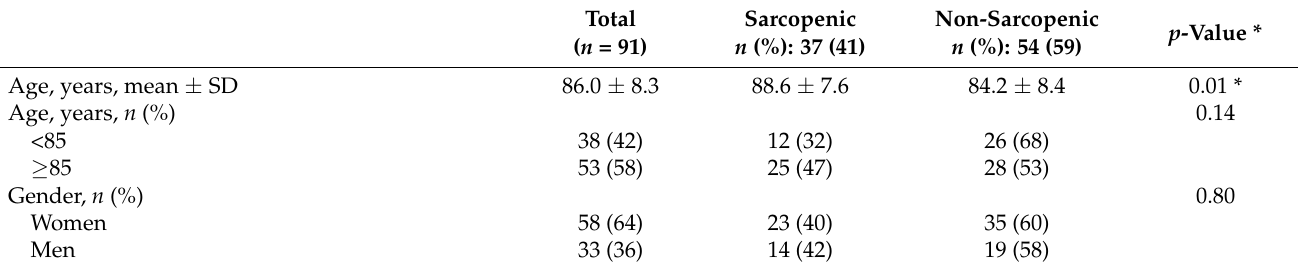
Table 1. Characteristics of the participants by sarcopenia